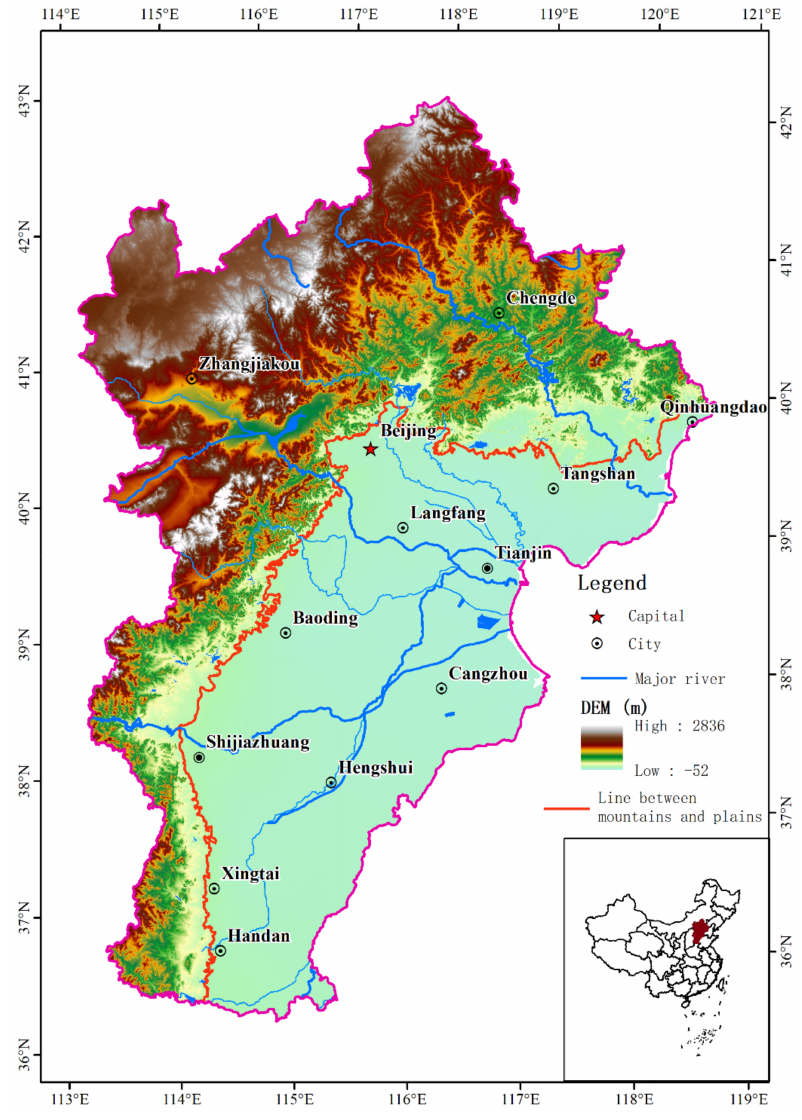
Figure 5. Overview of Jing-Jin-Ji